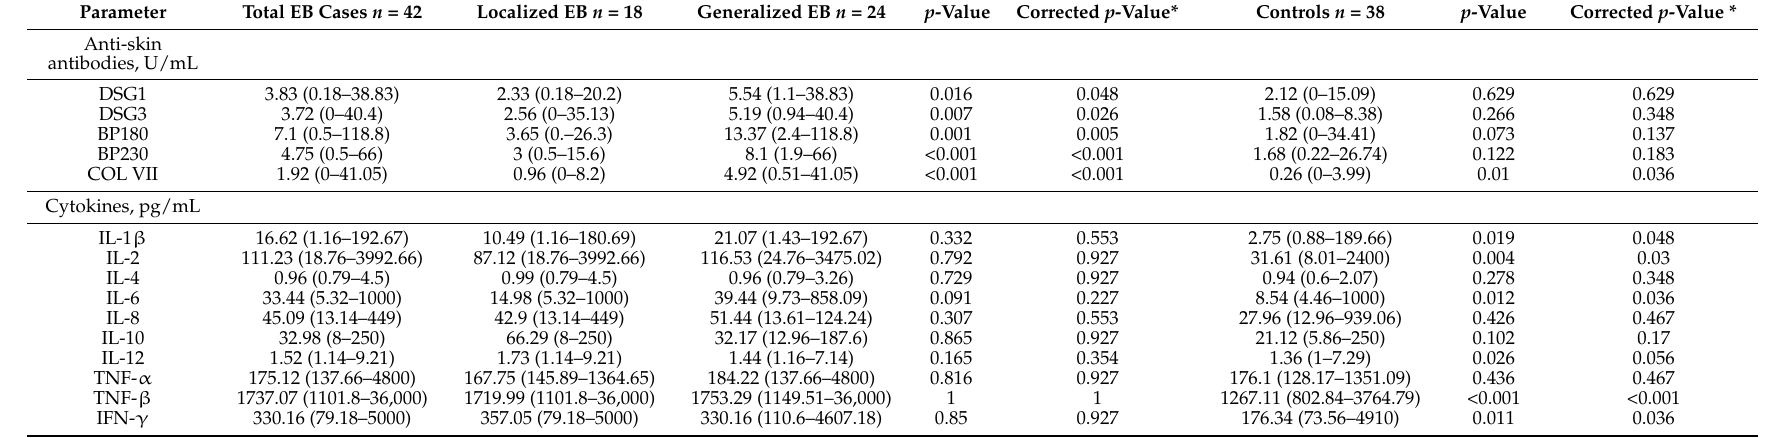
Table 3. Comparison between generalized and localized inherited epidermolysis bullosa types and healthy